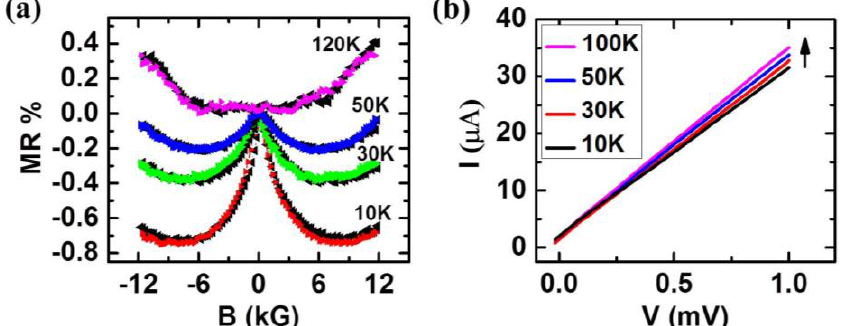
Figure 4. MR response of epitaxially-grown MLG on Cu Samples. ( a ) The device resistance, R (Ω), is measured in CPP geometry, and a negative MR is observed in the zz vicinity of the zero field. Measurements have been performed at a constant current bias of 1 mA. The negative MR gradually decreases with temperature and disappears above 50 K. The external magnetic field is parallel to the applied bias, (B || I). CPP resistance, R attains a minimum at ~0.6 T, and at higher magnetic field (>0.6 T), a positive MR is observed. Both scan directions of the magnetic field are presented in the plot; ( b ) Linear current-voltage ( I-V ) characteristics indicate the bias independence of the observed negative